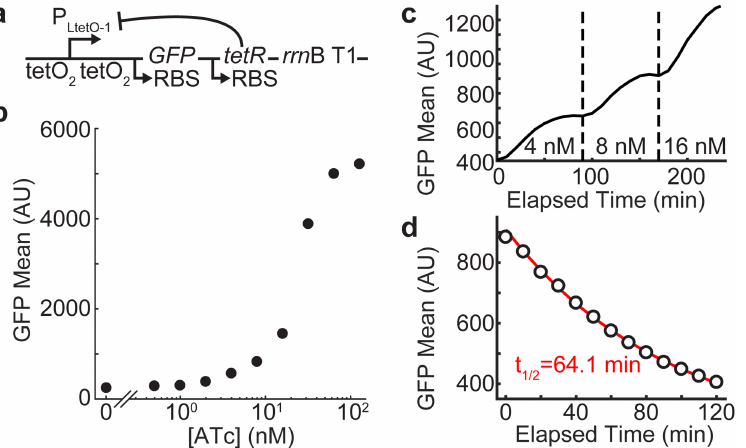
Fig 2. Characterization of induction dose-response and dynamics for bicistronic autoregulation circuit. ( A ) Schematic of autoregulatory construct, carried on a plasmid. The P LtetO-1 promoter encodesthe bicistronic transcript for GFP and TetR and is terminated at rrnB T1. TetR bindingto either of two tetO 2 sites represses transcription. ( B ) Flow cytometry analysisof pZH509 induction. Approximately a 50-fold change in expressionlevel across inductionrange (0–128nM ATc), with an 8-fold change in ATc (8 to 64 nM) giving a 6-fold increasein GFP expression. ( C ) Inductionkinetics for pZH509 measuredby flow cytometry; mean GFP fluorescence with ATc increasedfrom 0 to 4 nM at 0 min, 4 to 8 nM at 90 min, 8 to 16 nM at 170 min. In all cases the half-time of approaching equilibriumis ~30 min (occurring at ~30, 120, and 200 min). ( D ) Repression kinetics. Cells grown in 16 nM ATc were washedstarting at at t = –10 min and observedstarting at t = 0 min. The decreasein fluorescence from t = 10 min to t = 120 min is well fit by exponential decay with a half-time of 64.1